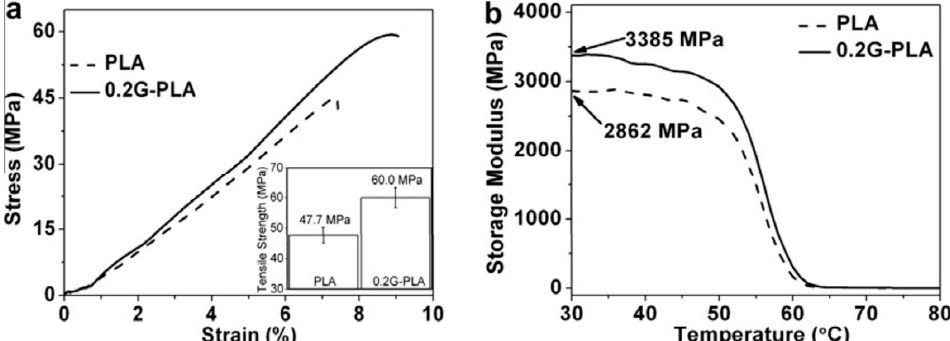
Figure 17. ( a ) Representative stress–strain curves; and ( b ) plots of storage modulus vs. temperature for PLA and 0.2GNS-PLA. The inset in ( a ) contains tensile strength values of PLA and 0.2GNS-PLA [75].